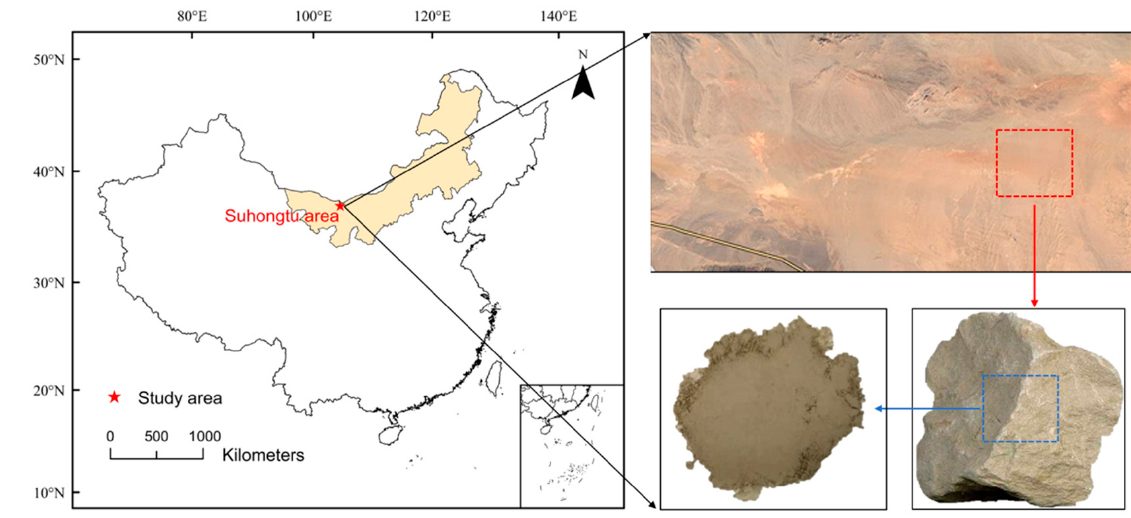
Figure 1. Claystone enclosures in the Suhongtu area.